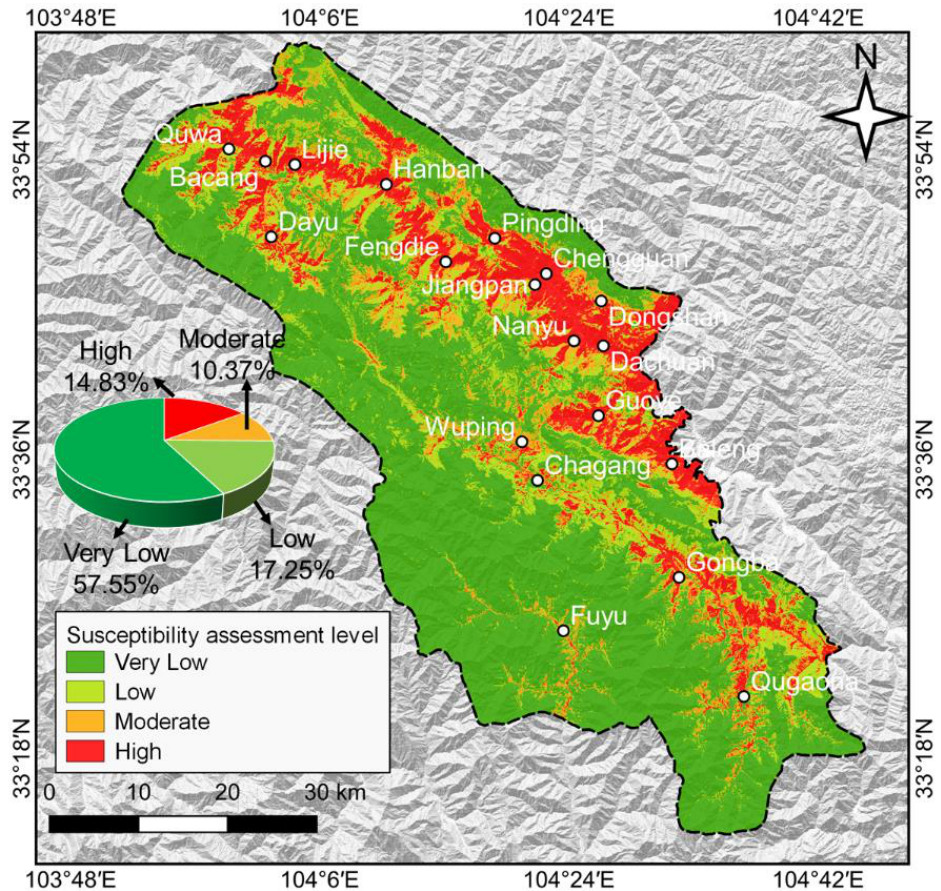
Figure 9. Susceptibility assessment levels in Zhouqu.